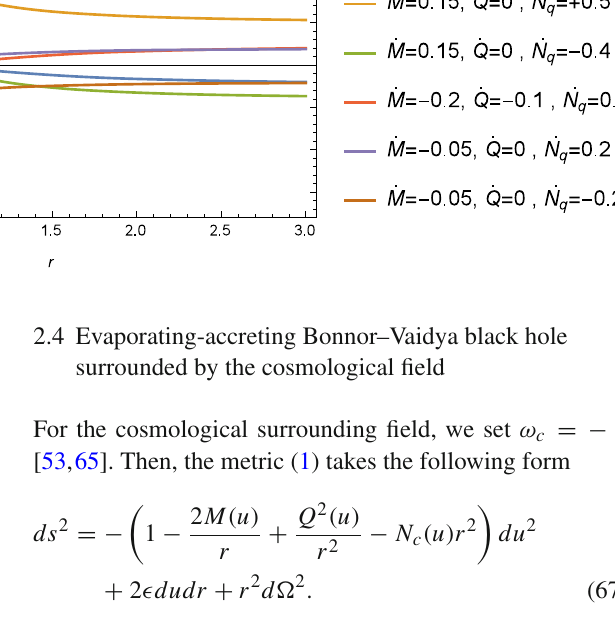
(yellow plot) versus 2